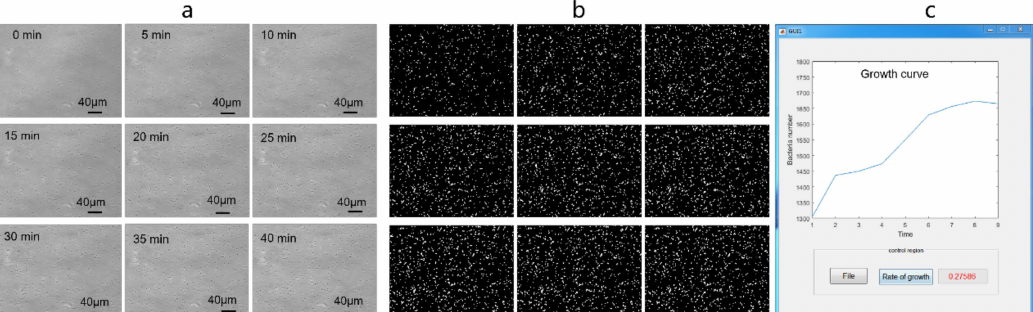
Figure 5. Analysis process of the automatic bacterial counting plug-in. ( a ) Photographs of bright-field microscopy images captured at defined times using a 40 × objective lens. The images were the original files imported into the plug-in. ( b ) Conversion of the bright-field photographs to binary images. ( c ) Growth curve generated in the visual